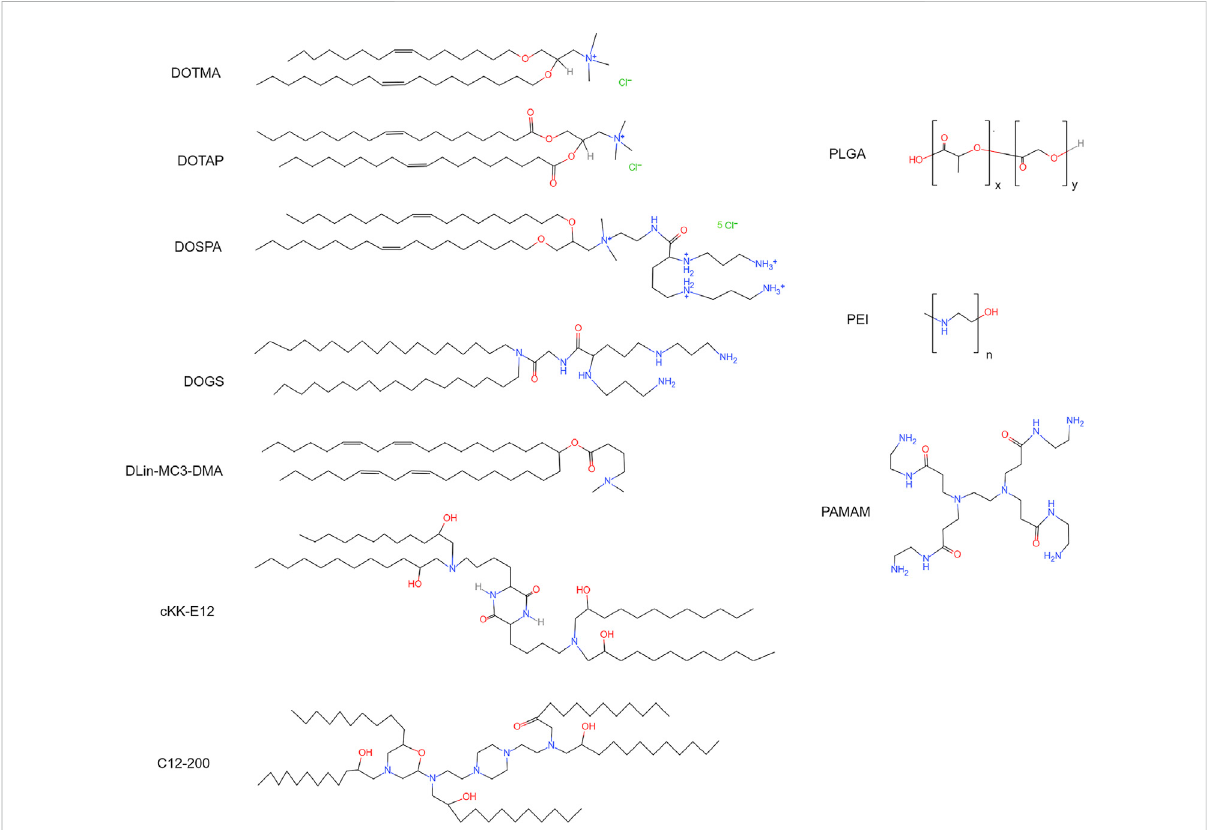
FIGURE 4 Chemicalstructuresofcationiclipids,ionizablelipids,andpolymers.DOTMA:1,2-di- O -octadecenyl-3-trimethylammonium-propane.DOTAP: 1,2-dioleoyl-3-trimethylammonium-propane. DOSPA: 2,3-dioleyloxy- N -[2-(sperminecarboxamido)ethyl]- N , N -dimethyl-1-propanaminium tri fl uoroacetate. DOGS: 2,5-bis(3-aminopropylamino)- N -[2-[di(heptadecyl)amino]-2-oxoethyl] pentanamide. DLin-MC3-DMA: heptatriaconta- 6,9,28,31-tetraen-19-yl-4-(dimethylamino) butanoate. cKK-E12: 3,6-bis(4-(bis(2-hydroxydodecyl)amino)butyl)piperazine-2,5-dione. C12- 200: 1,1 ′ -[[2-[4-[2-[[2-[bis(2-hydroxydodecyl)amino]ethyl](2-hydroxydodecyl)amino]ethyl]-1-piperazinyl]ethyl]imino]bis-2-dodecanol.